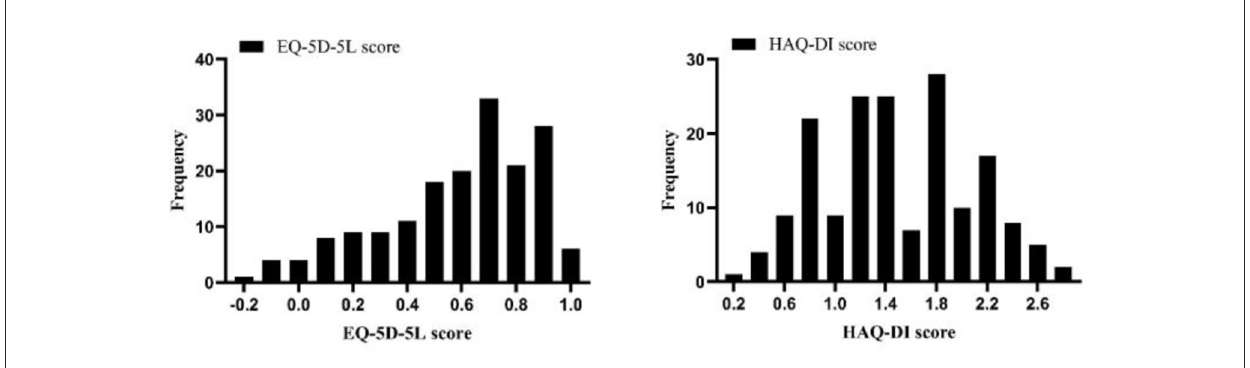
the data for these variables. Thus, we recommended choosing the combination according to the actual available data and selecting the mapping algorithm constructing based on Beta. Figure 2